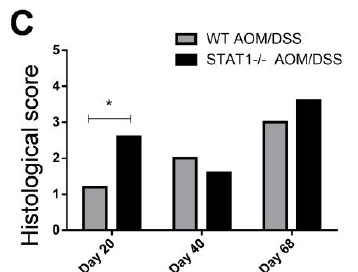
Figure 3. STAT1 deficient mice have more advanced dysplasia and goblet cell decreases compared to WT colons. The colons were removed, fixed, and stained with H&E ( A ) or Alcian blue ( B ) at the indicated time intervals. ( C ) The histological score shown in each group of mice was determined as mentioned in M&M and is expressed as mean ± SD. Scale bars: 50 µm. * indicate hyperplastic lymphoid node, arrow indicate numerous hyperplastic gland polyps and arrowhead atypical epithelial cells with dysplastic nucleus and mitotic figures. A remarkable decrease of goblet cells was observed at Day 40 in STAT1 − / − AOM/DSS. Demonstrative photographs and data are